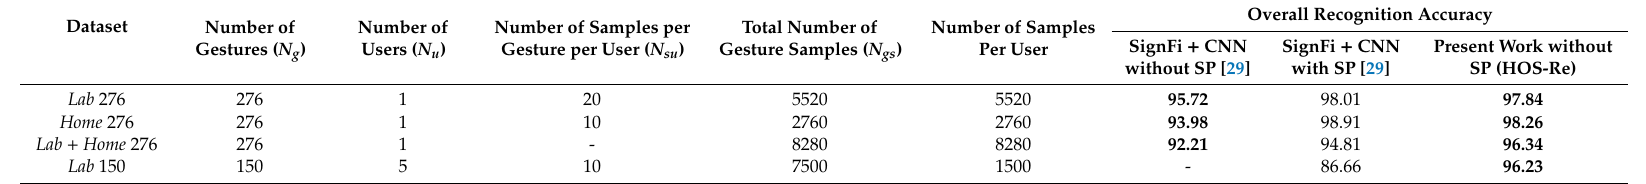
Table 3. Comparison of overall recognition accuracy.